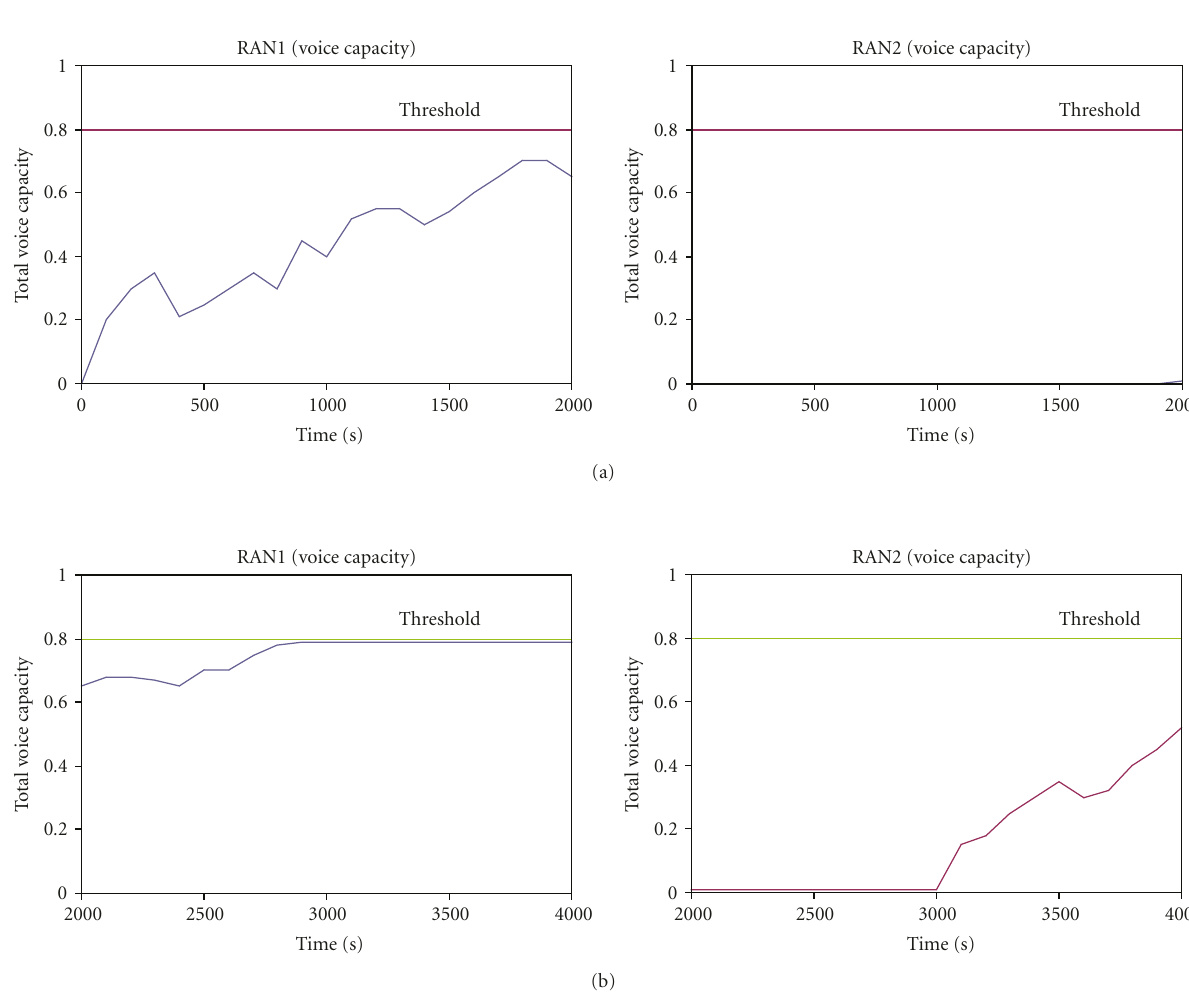
Figure 8: Voice tra ffi c distribution between the two